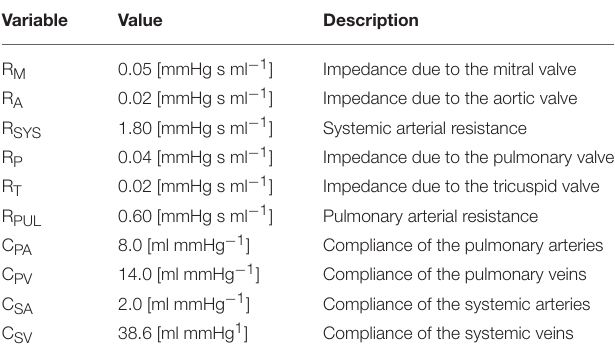
TABLE A2 | Parameter values and definitions for the lumped circulatory model.